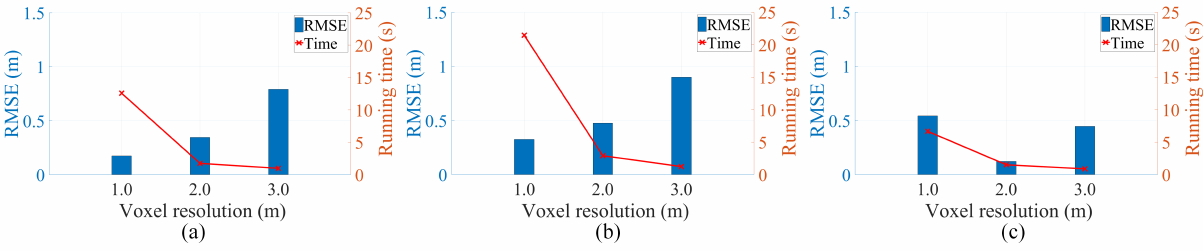
Figure 8. RMSE and running time of the test using RESSO dataset with different overlapping ratios.